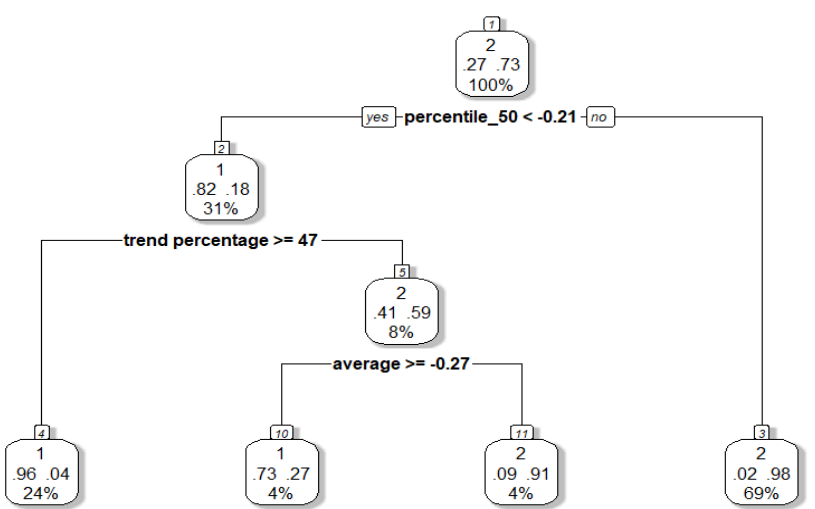
Figure 4. Classification tree obtained from the plots analyzed in this study. Each of the rectangles represents a node with its classification rule. Inside the rectangle of each node it is the proportion of cases belong to each category (%) and the proportion of the total data that has been grouped there (%). Table 2. Statistical analysis including equation and description of each indicator.